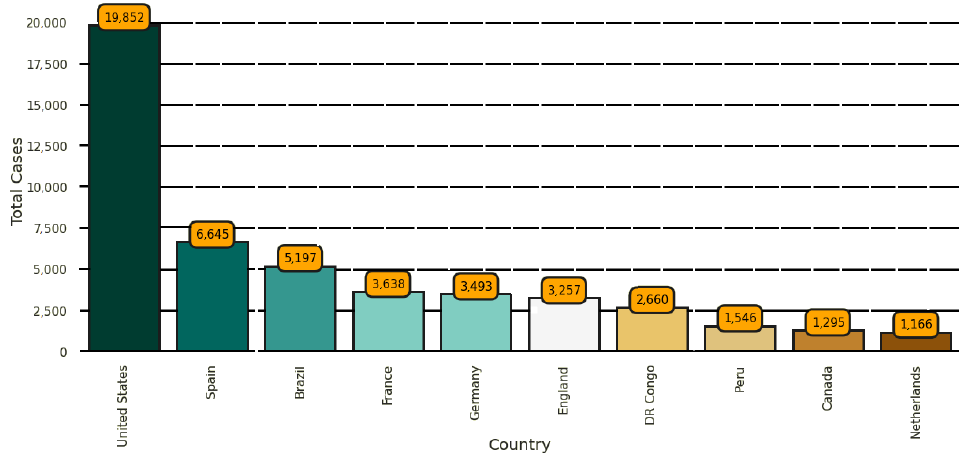
Figure 7. Sample set of images from the monkeypox dataset.